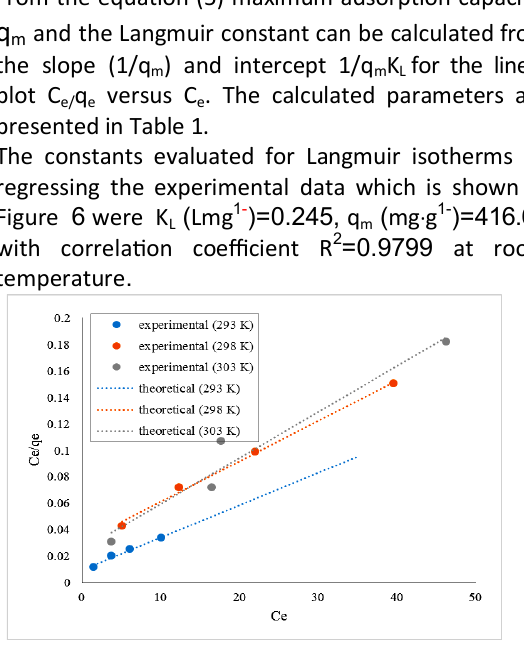
Fig. 6. Linear form of Langmuir isotherm model, experimental condition: рН= 6.0, room temperature 293